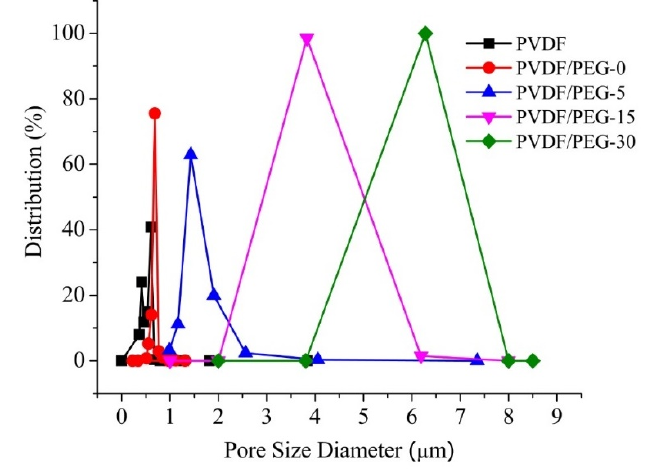
Figure 4. The pore size distribution of the resulting membranes.